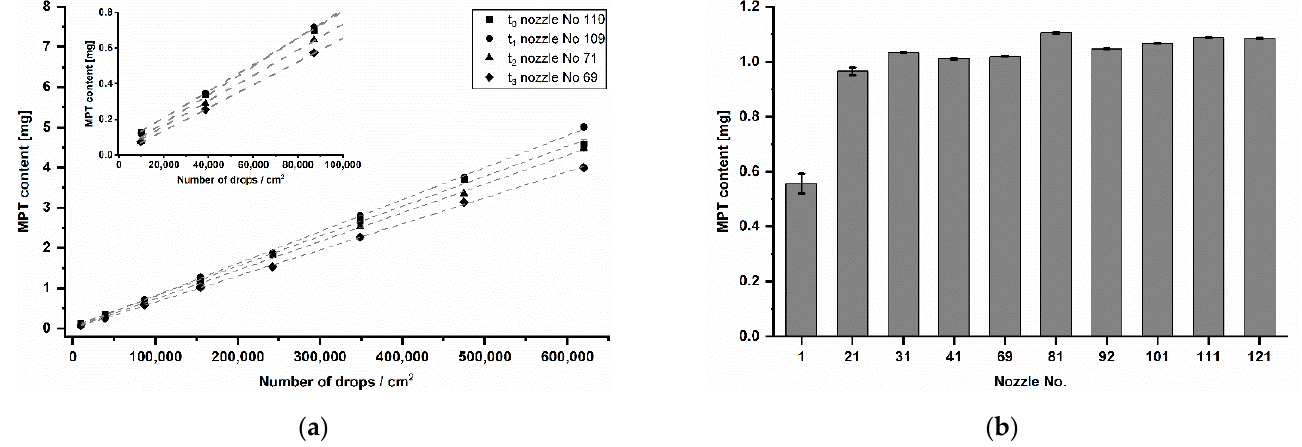
Figure 9. ( a ) Calibration series of printing resolution at different time points (t 0 –t 3 ) distributed over five months, mean ± SD ( n = 3). ( b ) MPT content of samples printed at 1000 dpi with ten different nozzles on the same day in randomised order, mean ± SD ( n = 3).